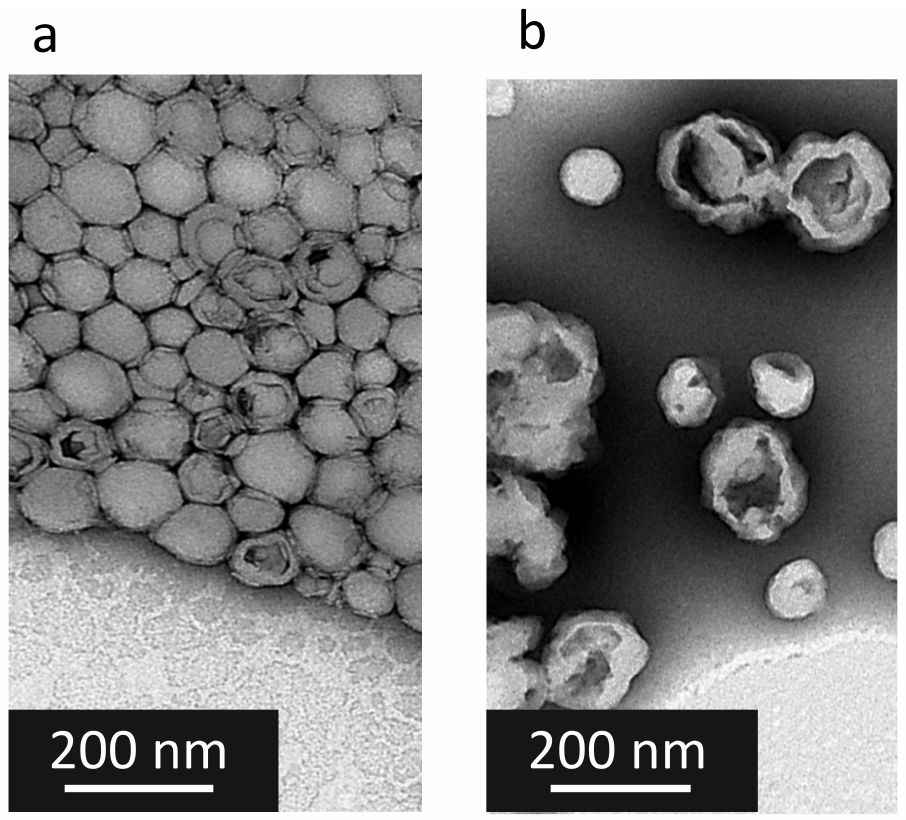
Figure 4. TEM images of ( a ) CFX–DOTAU NP and ( b ) On α 600